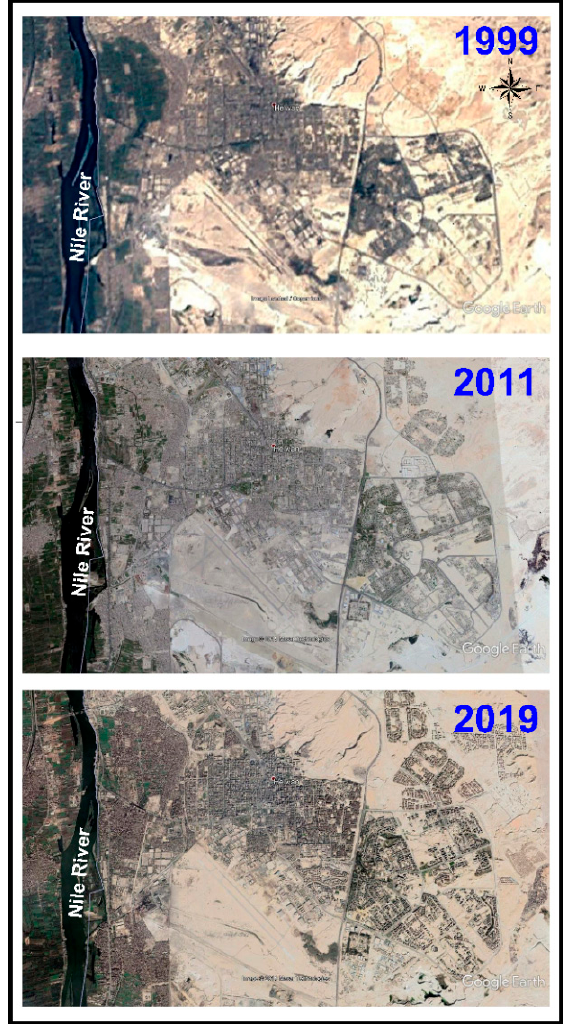
Figure 1. Comparison of the urbanization pattern during 1999, 2011, and 2019 on Helwan City. Geologically, the investigated site is bordered to the east and north as well as to the northwest by known geological plateaus, such as the observatory plateau that bounds the studied area from the northwest, and the Qurn Plateau that borders the study area from the east, in addition to the Halawan highlands that are located southeast of the study area [11–13]. These plateaus can be described as the following: (1) an observatory plateau that varies from 117–150 m, which descends a very simple slope towards the south and southwest and consists of limestone rocks and dolomitic limestone of the upper part of